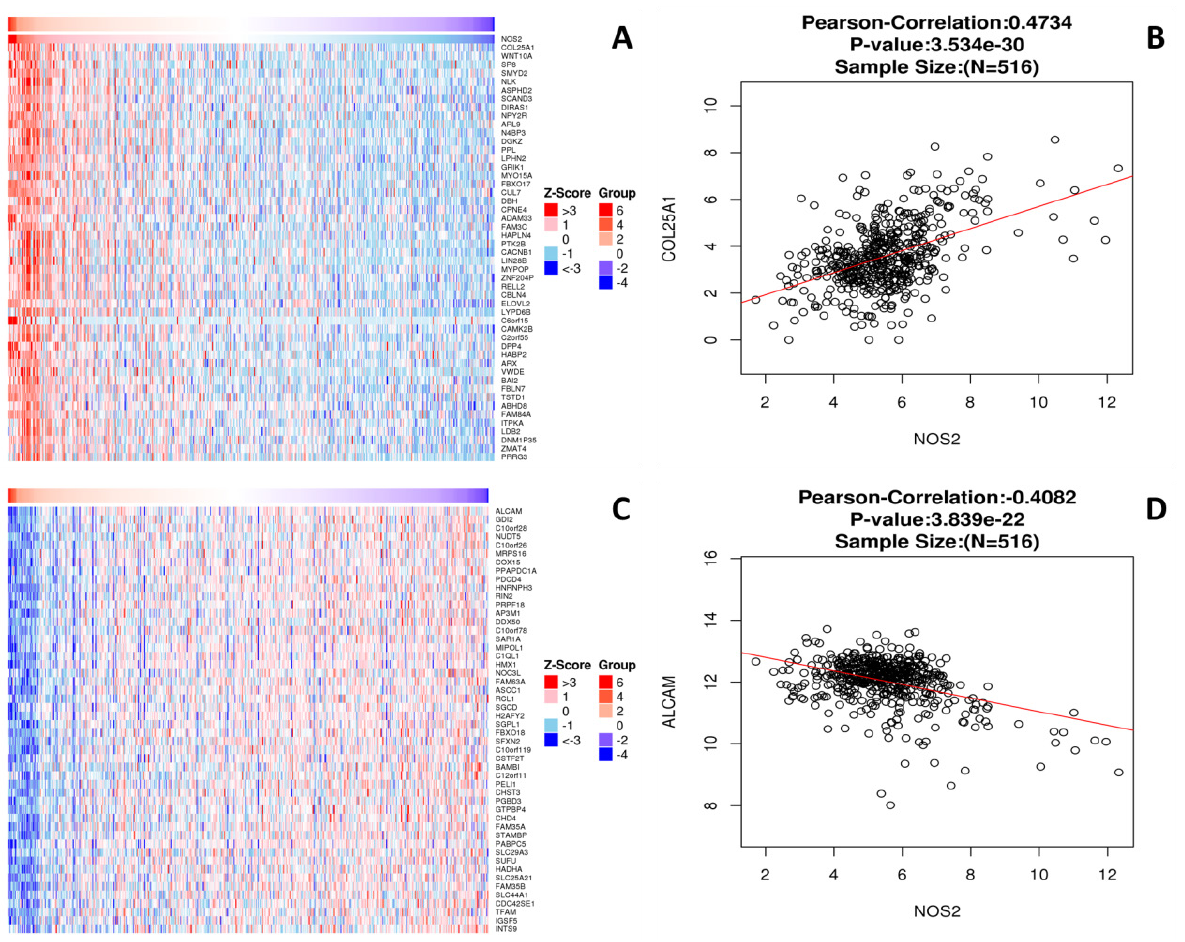
Figure 5: Co-expressed genes relevant to iNOS/NOS2 analysis (A: Heat-map of genes positively correlated with iNOS/NOS2; B: Top gene positively correlated with iNOS/NOS2; C: Heat-map of genes negatively correlated with iNOS/NOS2; D: Top gene negatively correlated with iNOS/NOS2 ).